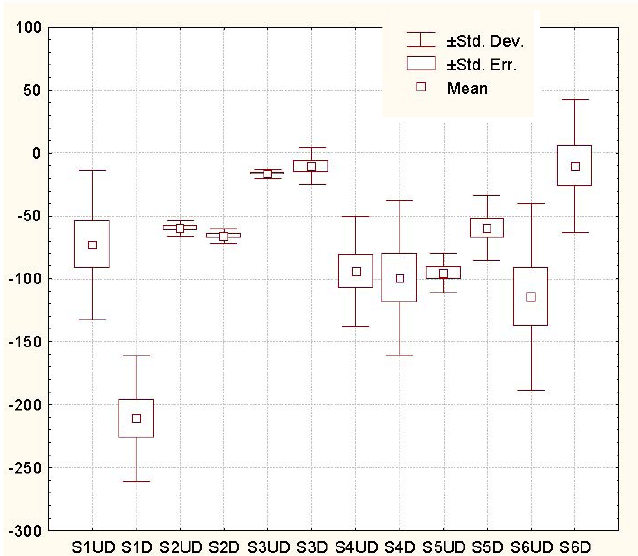
Figure 4: A box and whisker plot (of C micro-volts) for each subject is shown.